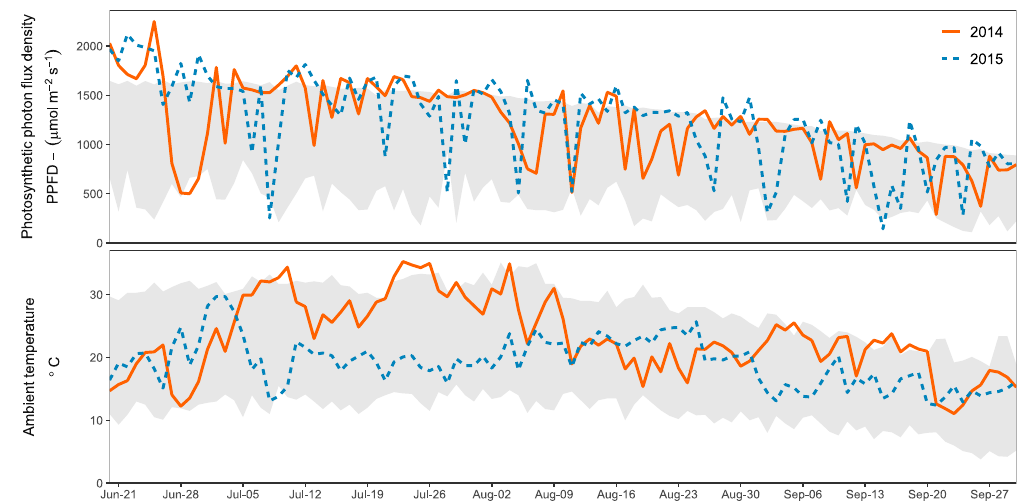
Figure 2. Solar irradiance (PAR) together with ambient temperature during the vegetation periods of 2014 and 2015 at the research station in Vassbo, Sweden (lat. 60.53°; long. 15.53°). The lines for the corresponding years indicate the maximum daily values of instantaneous photon flux density for photosynthetic radiation (PPFD) expressed in μ mol·m − 2 ·s − 1 and ambient temperature in ° C. The grey bands show the range of historical values reported by the Swedish Meteorological and Hydrological Institute (SMHI) [68,69].